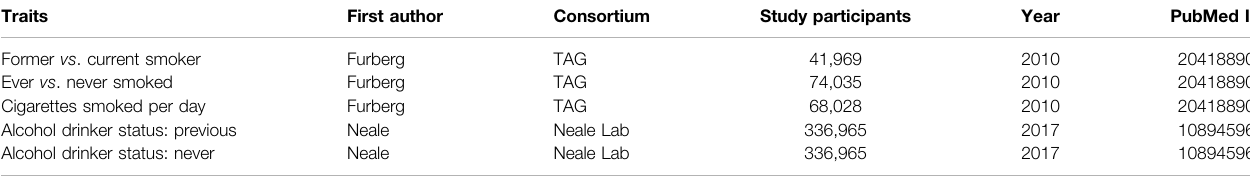
TAG, Tobacco and Genetics consortium.